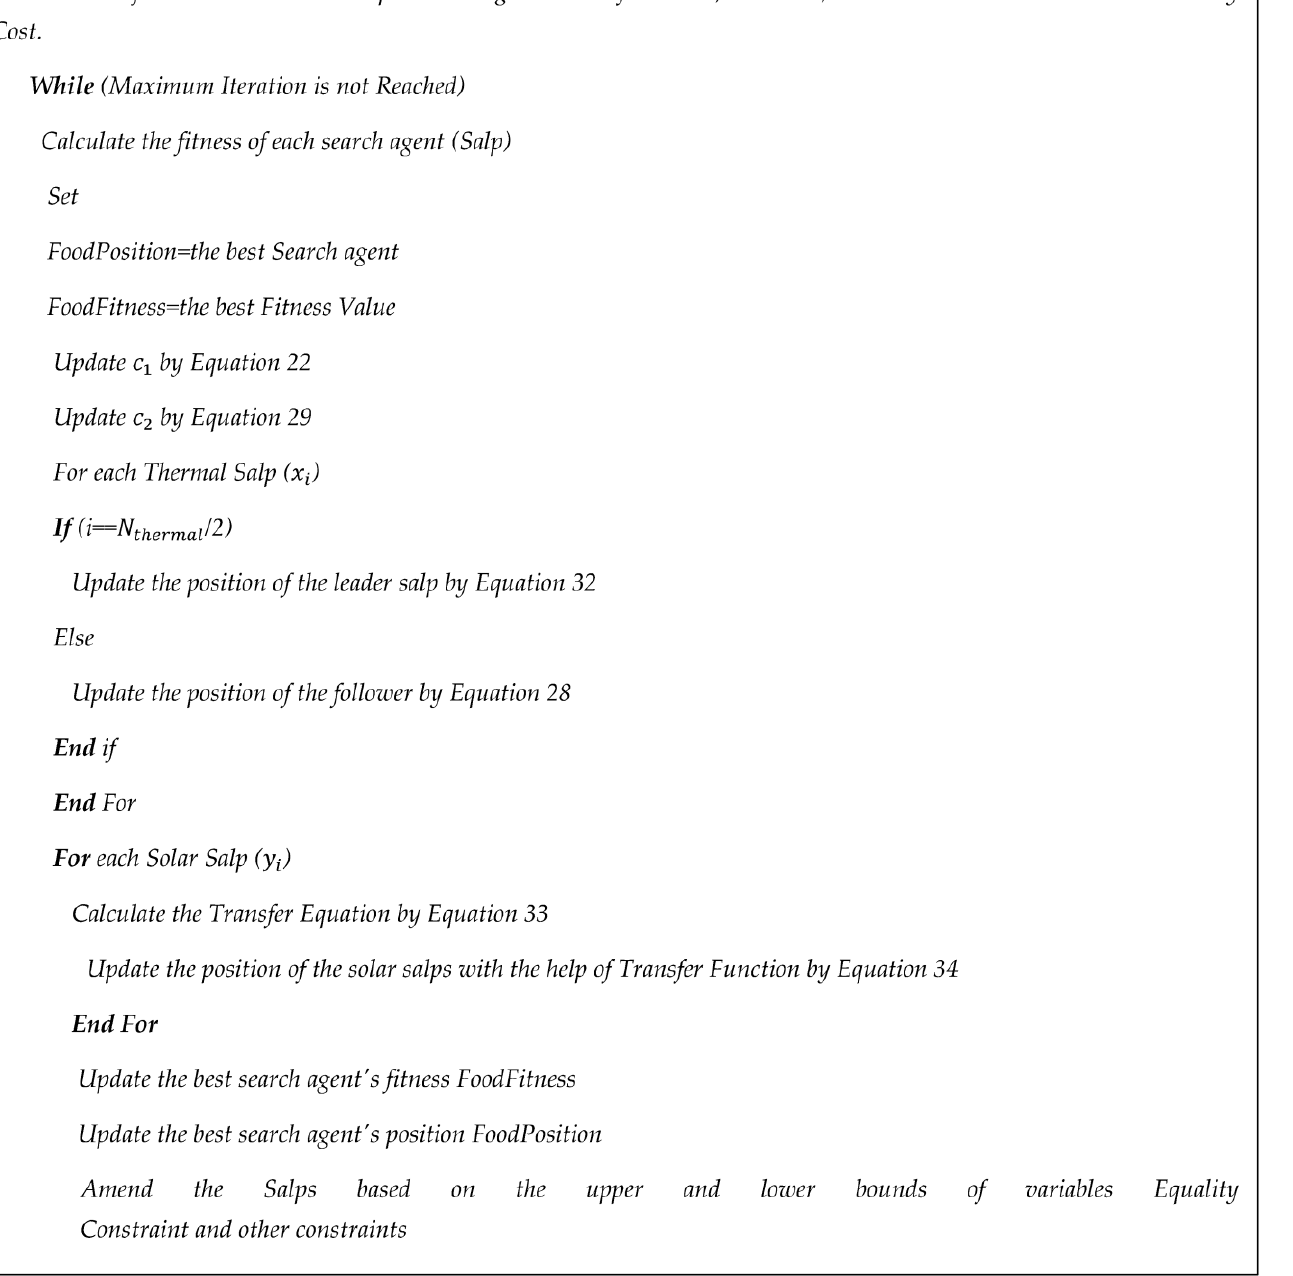
Figure 3. Pseudo-code of CISSA.